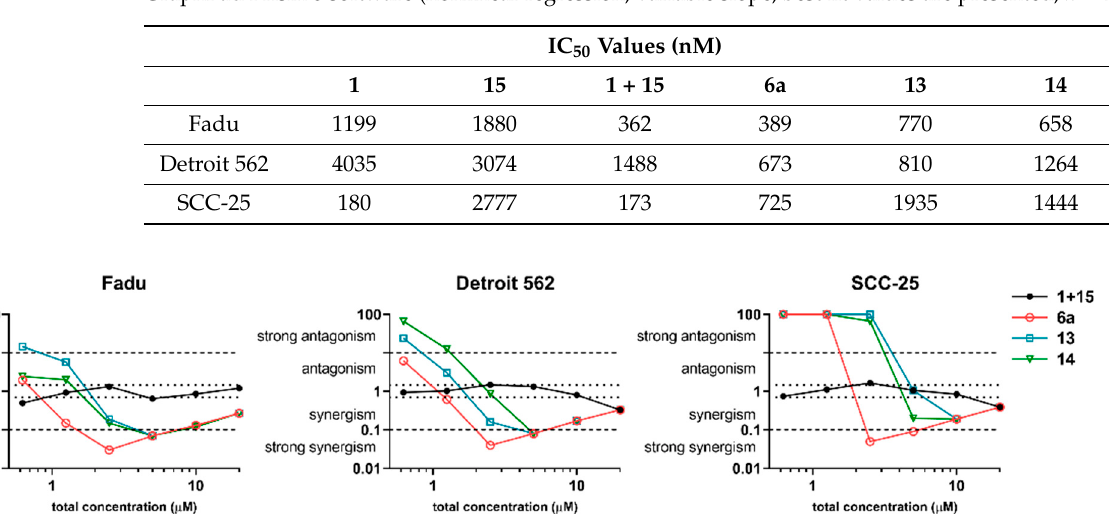
Figure 4. Concentration-dependent visualization of combination index of hybrids ( 6a , 13 and 14 ) and their fragments: erlotinib ( 1 ) and chalcone ( 15 ) in 1:1 mixture. Combination index was calculated by CompuSyn using the mean values of cell viability data measured by CellTiter-Glo after 72 h treatment and 72 h postincubation. Total concentration means the overall concentration of 1 and 15 either in combination or in hybridized form.